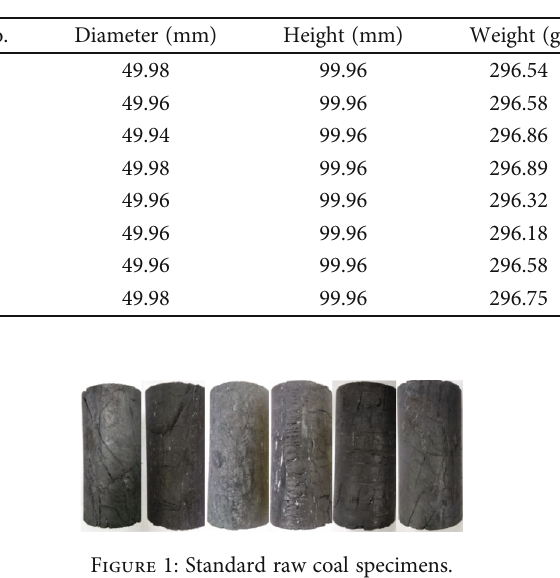
Table 1: The basic parameters of raw coal samples.